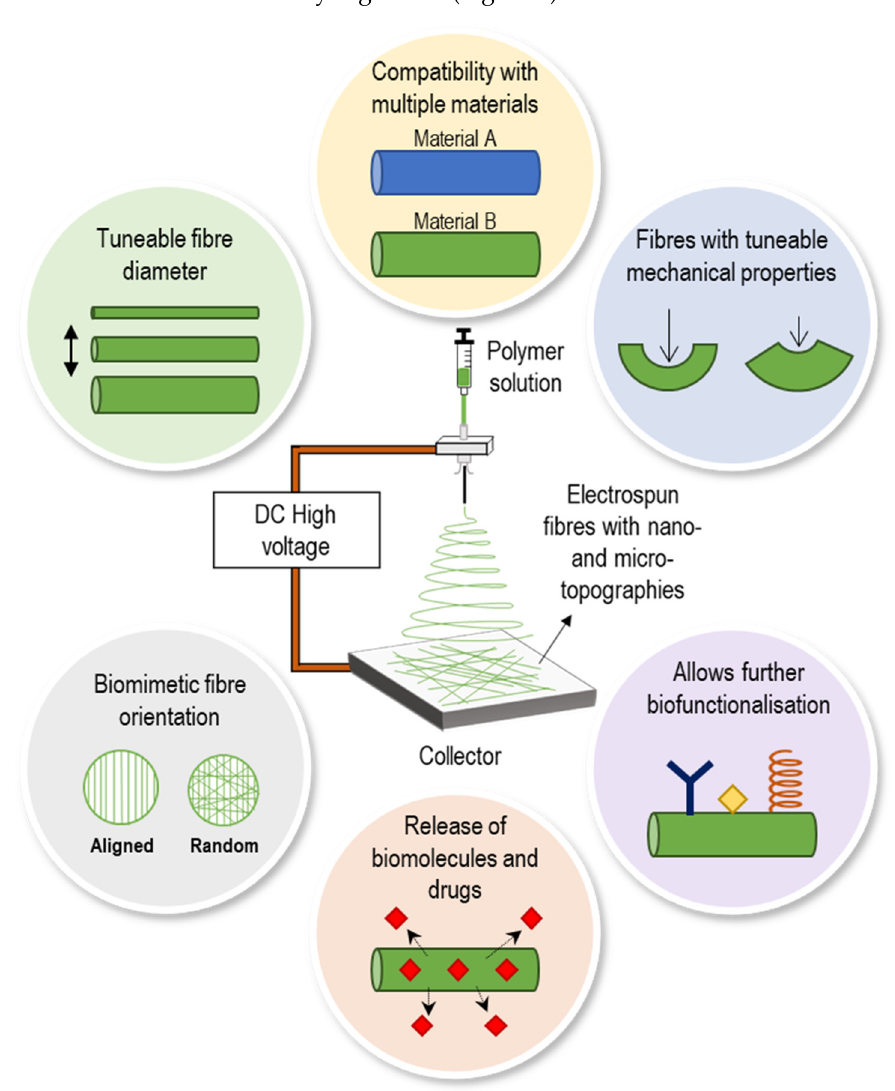
Figure 1. Schematic of an electrospinning setup and description of some of its features with interest in kidney tissue engineering.